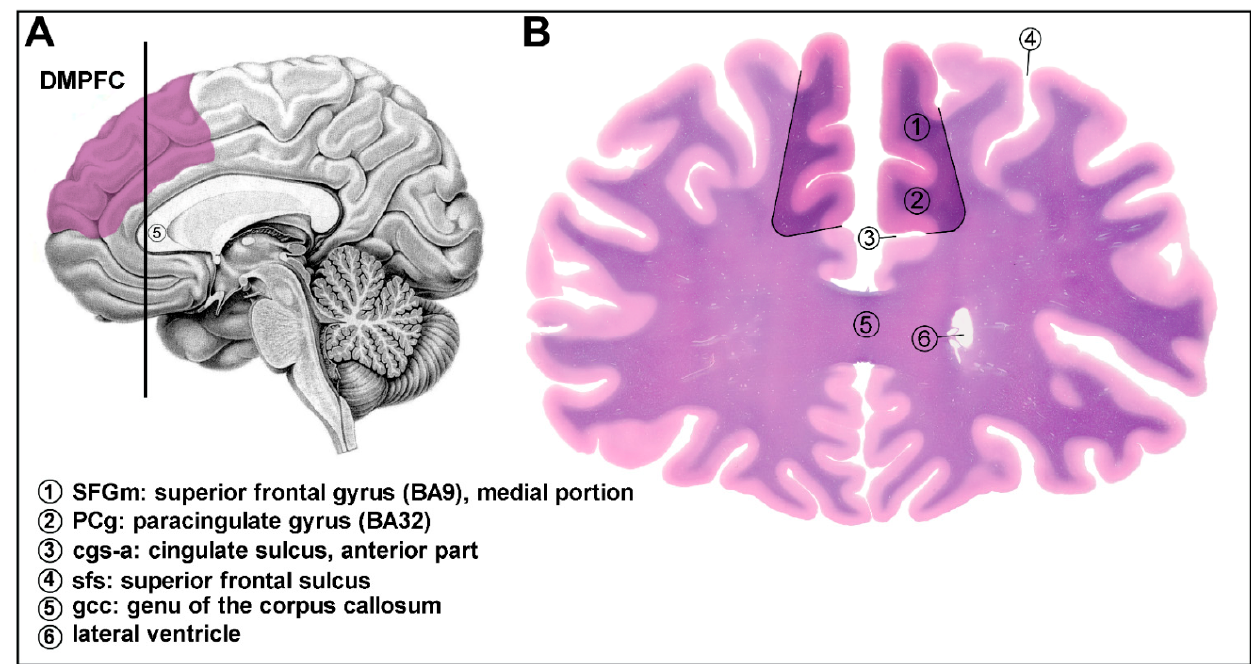
Figure 8. A representative view of the human brain region was dissected in the study. Details on the anatomical origin and structure of the dissected region. ( A ) The location and topographical extension of the dissected area, the dorsomedial prefrontal cortex (DMPFC) is shown in lilac color on the medial surface of the human brain. The vertical black line represents the cutting line used to obtain the coronal section illustrated on the right panel. ( B ) Coronal section of the human brain represents the DMPFC (1 + 2). The dissected area analyzed in this study is highlighted and demarcated by black lines. Landmarks and boundaries are notified by numbers. The section was stained using the Levanol-Fast Cyanine 5RN method.